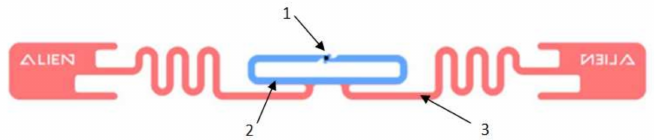
Figure 1. Ultra-high frequency (UHF) radio frequency identification (RFID) passive tag architecture